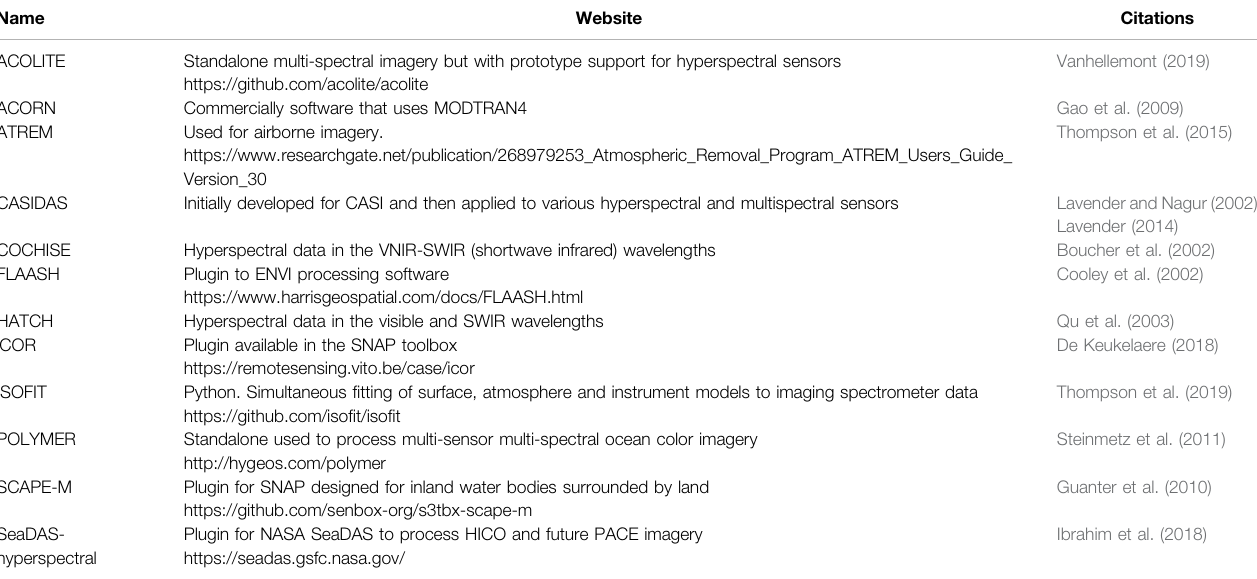
TABLE 3 | Atmospheric correction approaches for aquatic